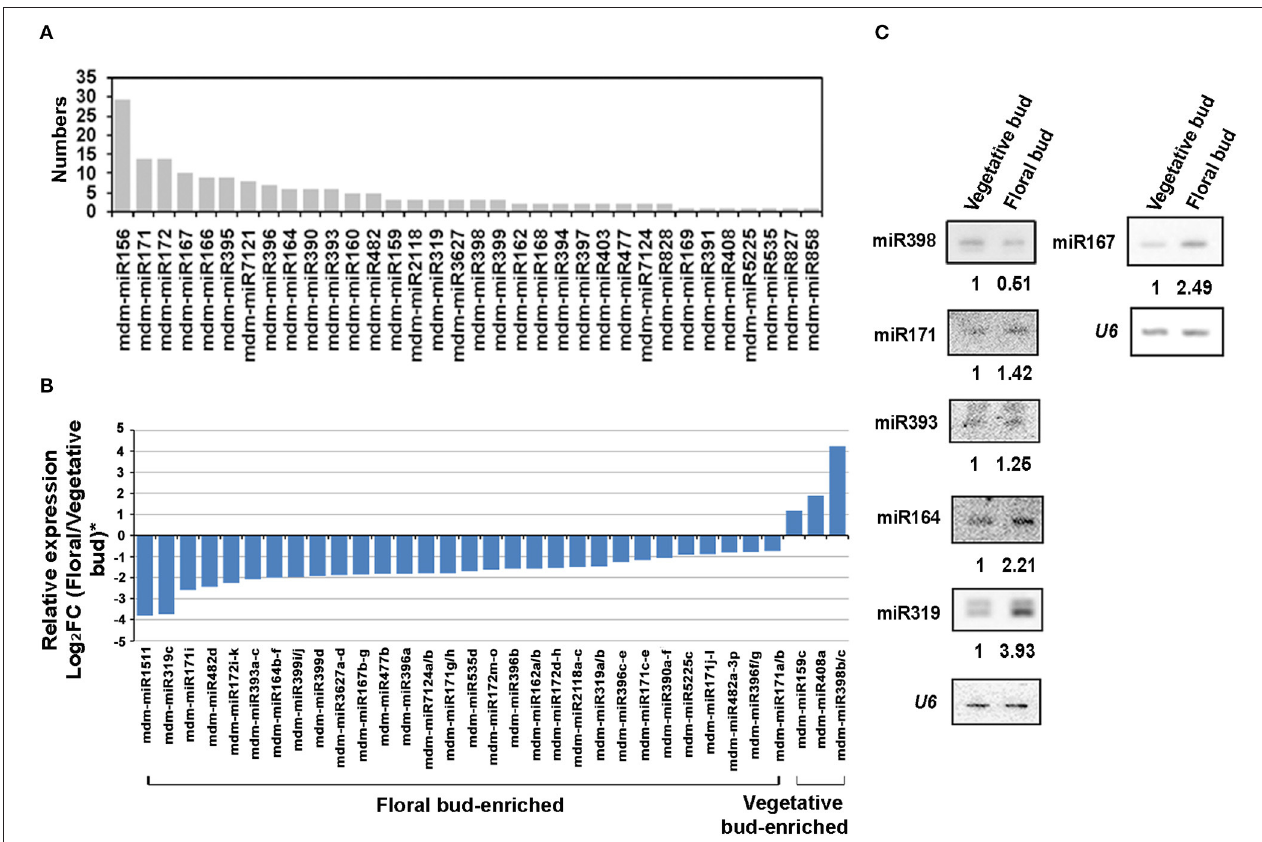
FIGURE 2 | Differentially expressed miRNAs during floral transition of Malus domestica. (A) Numbers of known miRNA family members identified in apple vegetative and floral bud. (B) Expression pattern of differentially expressed known miRNAs (DE known miRNAs) between vegetative and floral bud. Expression level was set as Log 2 Fold Change (FC, floral bud/vegetative bud). (C) RNA gel blot for some DE known miRNAs. U6 served as a loading control. * All the values were given as Log 2 CPM (Counts per